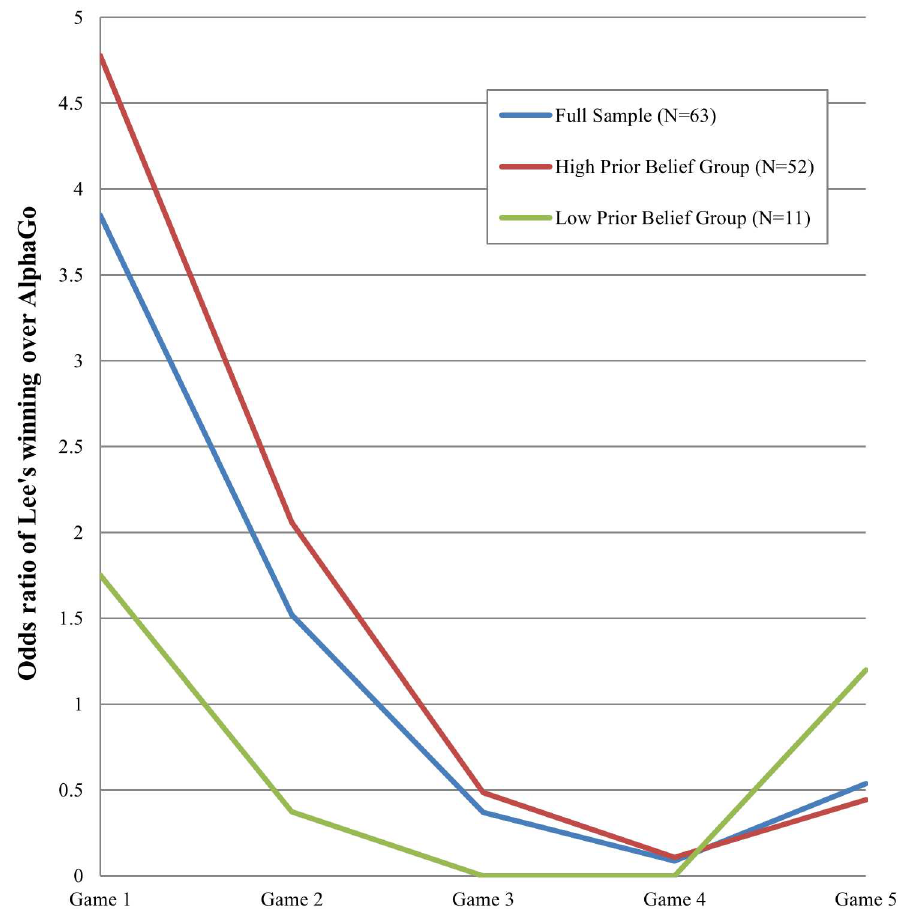
Fig 3. Temporal variation in the prediction of Lee’s winning. Y axis refers to the odds ratio of those who predicted Lee’s winningover AlphaGo. The numberof participants( N ) is